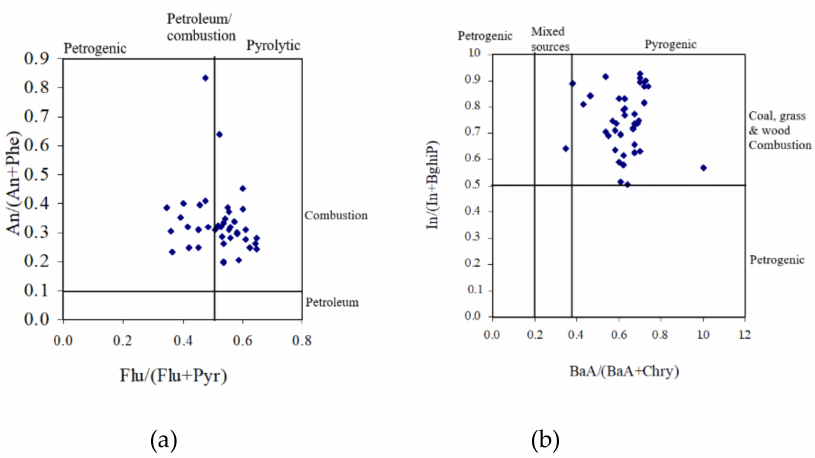
Figure 4. ( a ) 100% ratios of AN/(AN + Phen) were >0.1; ( b ) 100% mainly combustion sources while that of BaA/(BaA + Chry) ranges from 0.5 to